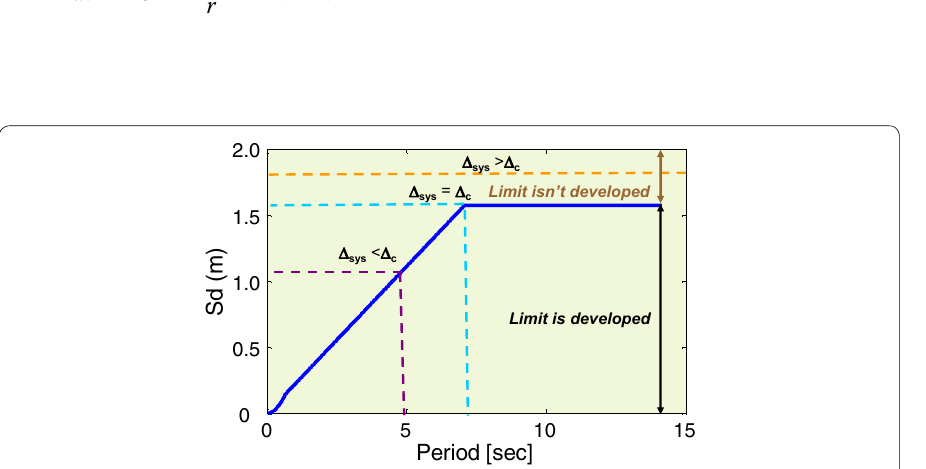
Fig. 1 Graphical representation of the